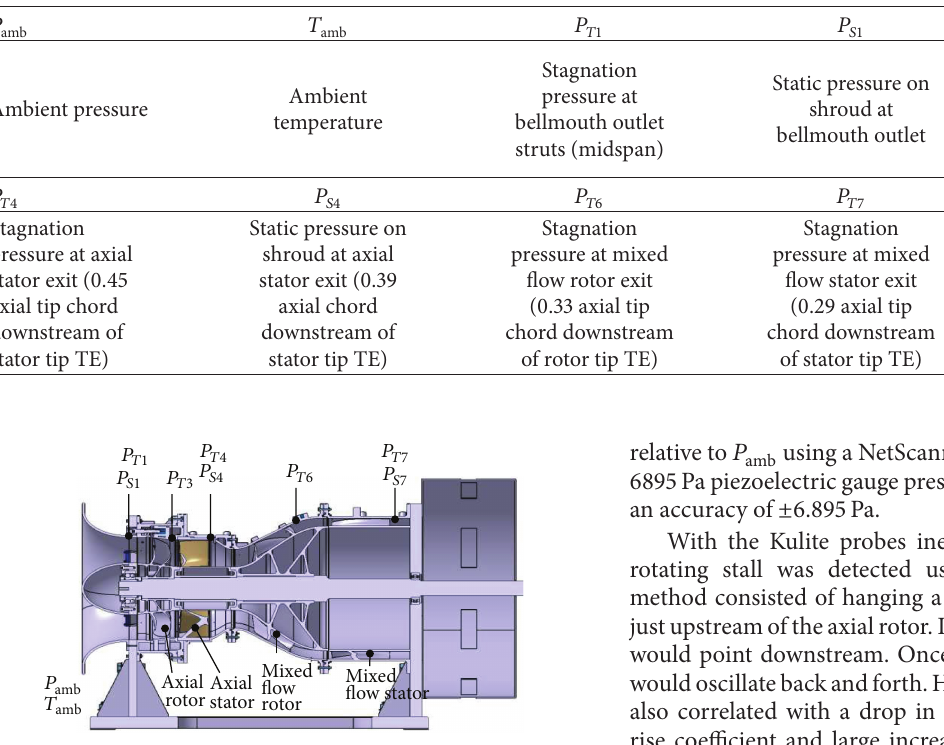
Table 3: Summary of rig instrumentation used in the study.